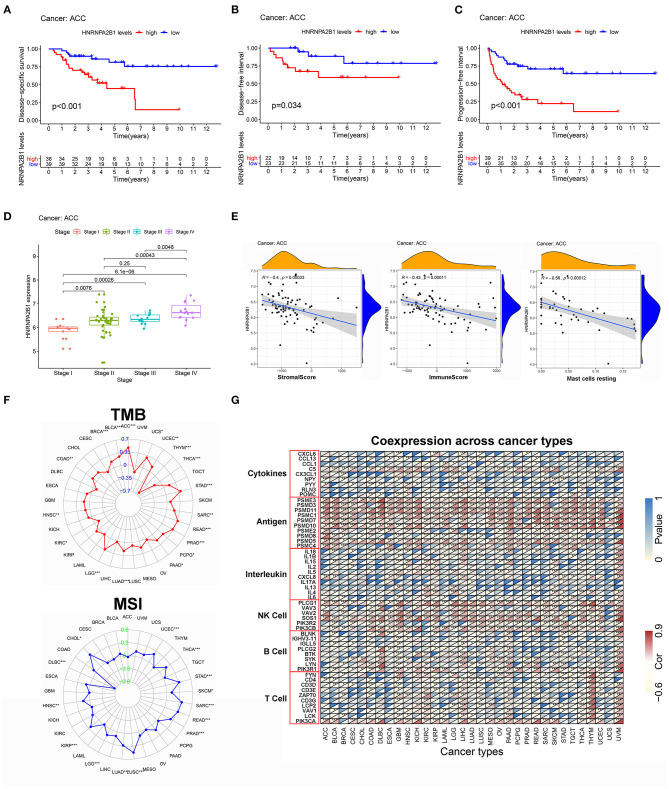
The pan-cancer analysis of HNRNPA2B1. (A) The relationship between HNRNPA2B1 expression and DSS. (B) The relationship between HNRNPA2B1 expression and DFI. (C) The relationship between HNRNPA2B1 expression and PFI. (D) The HNRNPA2B1 expression was significantly correlated with TNM stage. (E) The correlation among HNRNPA2B1 expression and immune landscape. (F) Pan-cancer analysis of the relationship between HNRNPA2B1 expression and TMB (above) or MSI (below). (G) The correlation among HNRNPA2B1 expression and immune-related mRNAs.